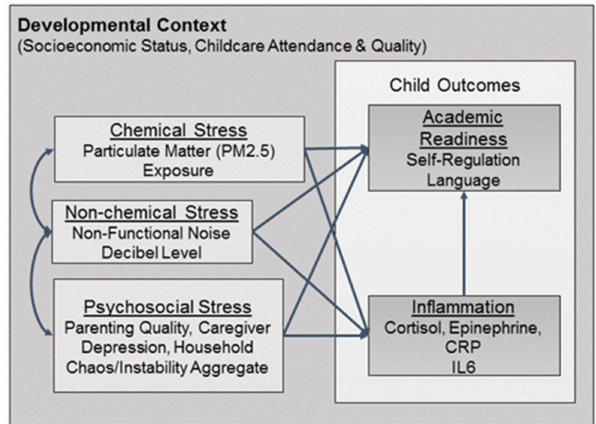
Figure 1. Schematic displaying the complex interactions between chemical, non-chemical, and psychosocial stressors, and child outcomes, including academic readiness and inflammation. PM2.5: Fine Particulate Matter < 2.5 micrograms per cubic meter air (ug / m 3 ); CRP: C-Reactive Protein; IL6: